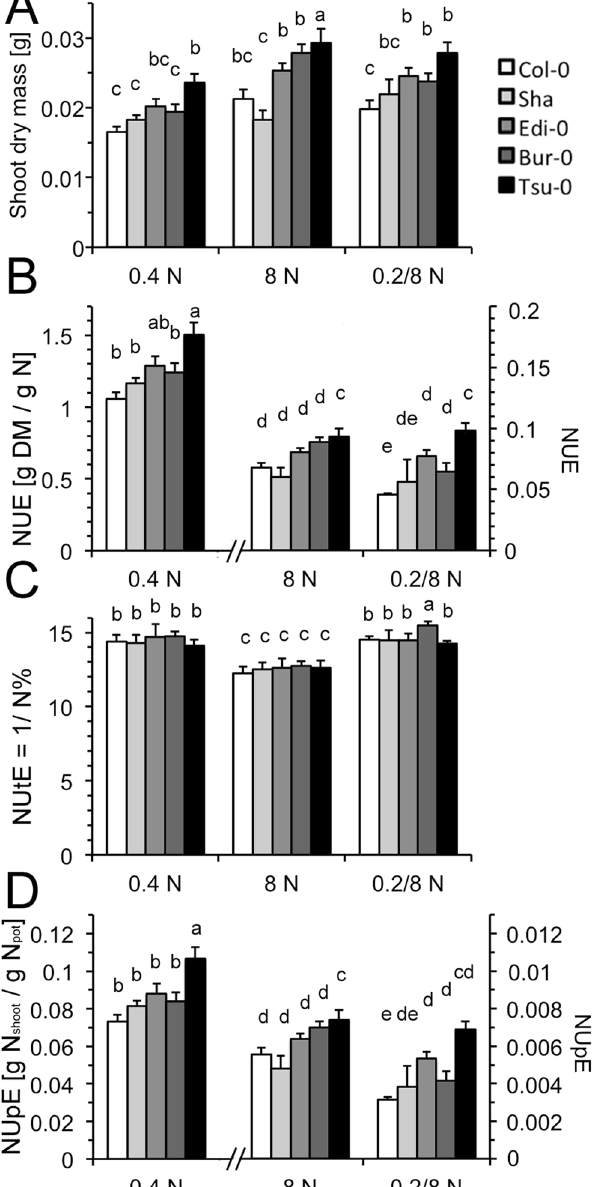
Figure 1. Nitrogen Use Efficiency parameters of contrasting Arabidopsis accessions. Plants were grown for 5 weeks on the indicated nitrogen conditions. ( A ) Shoot biomass ( B ) NUE, ( C ) NUtE ( = 1/shoot N%) ( D ) NUpE. Note the different scales for 0.4 N ( = 0.2 mM NH 4 NO 3 ), left axis, and 8 N ( = 4 mM NH 4 NO 3 ) and 0.2/8 N ( = 0.1 mM (NH 4 ) 2 SO 4 + 8 mM KNO 3 ), right axis. NUE = Nitrogen use efficiency (dry shoot biomass/N in pot), NUtE = Nitrogen utilization efficiency (dry shoot biomass/shoot N), NUpE = Nitrogen uptake efficiency (shoot N/N in pot). Three independent repetitions with each n = 6 per accession and N-regime were performed. Data are given as means ± SD from one experiment to avoid normalization between different experiments. Statistically significant differences (ANOVA, p < 0.01) are indicated with different